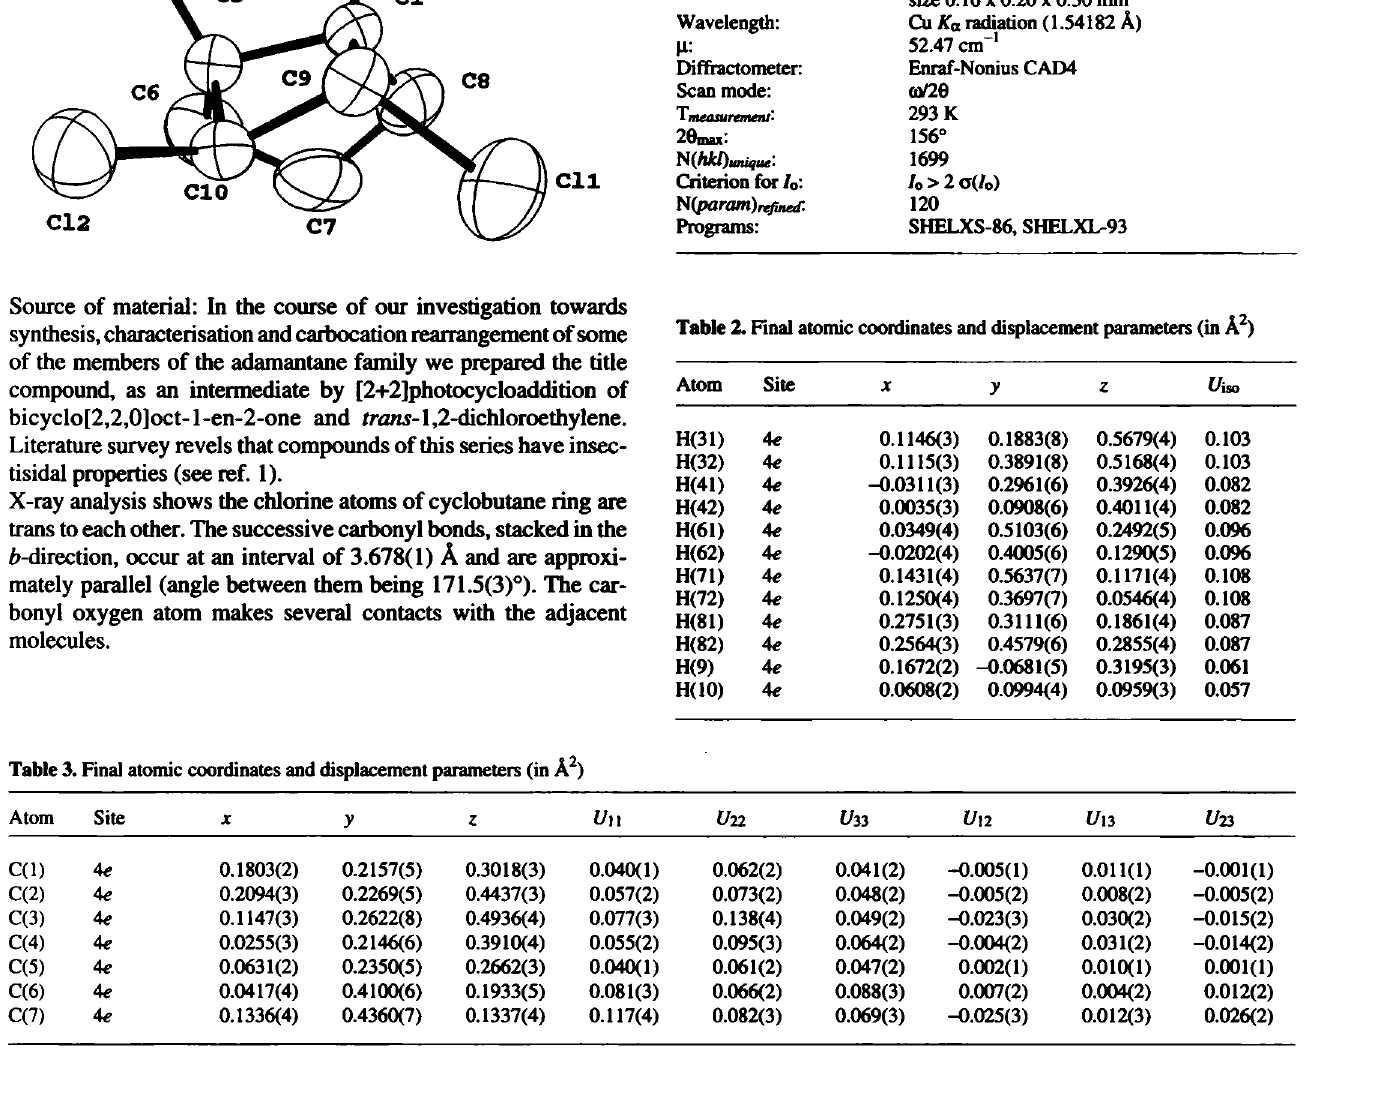
Table 1. Parameters used for the X-ray data collection Crystal: Wavelength: